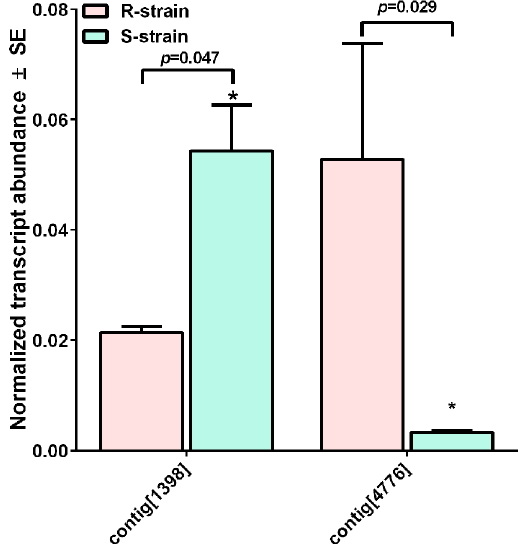
Figure 3. The transcriptional abundances of two aminopeptidase genes (contig[1398] and contig[4776]) in larval guts of R-strain (red) and S-strain (green) in the absence of Cry1Ab exposure as evaluated by RT-qPCR. The symbol “*”denotes statistical difference at 0.05 between R- and S-strain larvae (Student’s t -test).